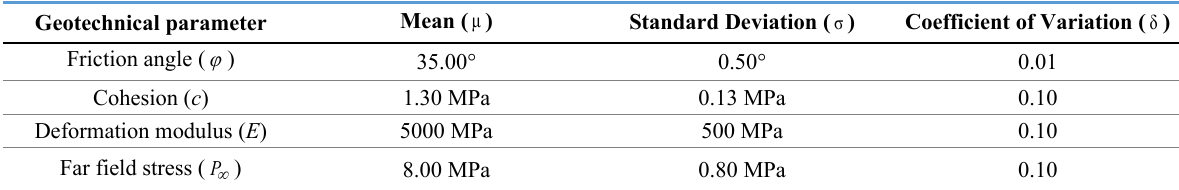
Table 2: Geotechnical statistical parameters for tunnel B [24].